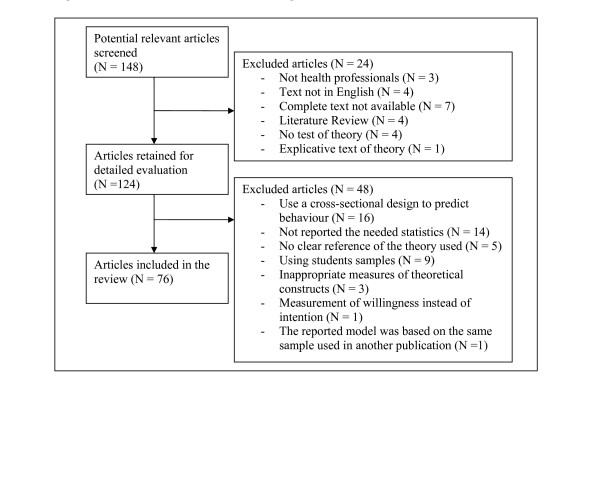
The QUORUM statement flow diagram.